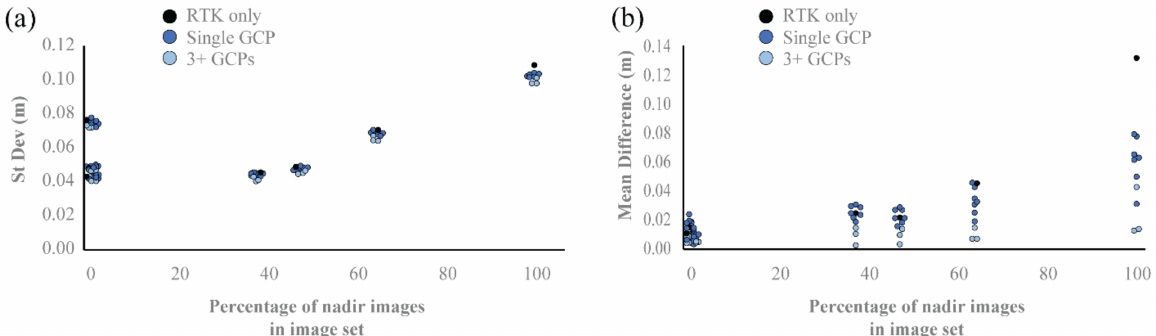
Figure 7. M3C2 error (y-axis) with respect to the percentage of nadir images within an image set used in UAV-SfM processing. ( a ) standard deviation of errors; ( b ) mean error. Black points represent results for RTK-only DG (no GCPs) and lightest blue use >3